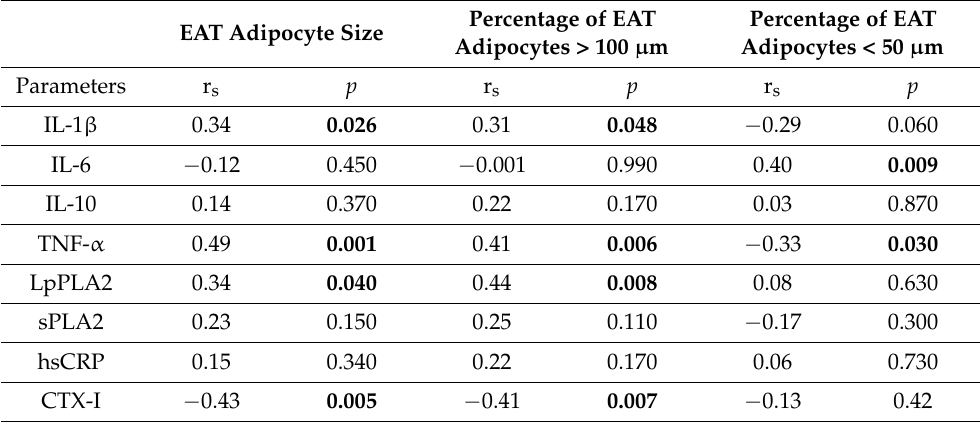
Table 6. Correlations of EAT adipocyte size, percentages of large and small adipocytes with biomark- ers of inflammation and extracellular matrix remodeling. Percentage of EAT EAT Adipocyte Size Adipocytes > 100 µ